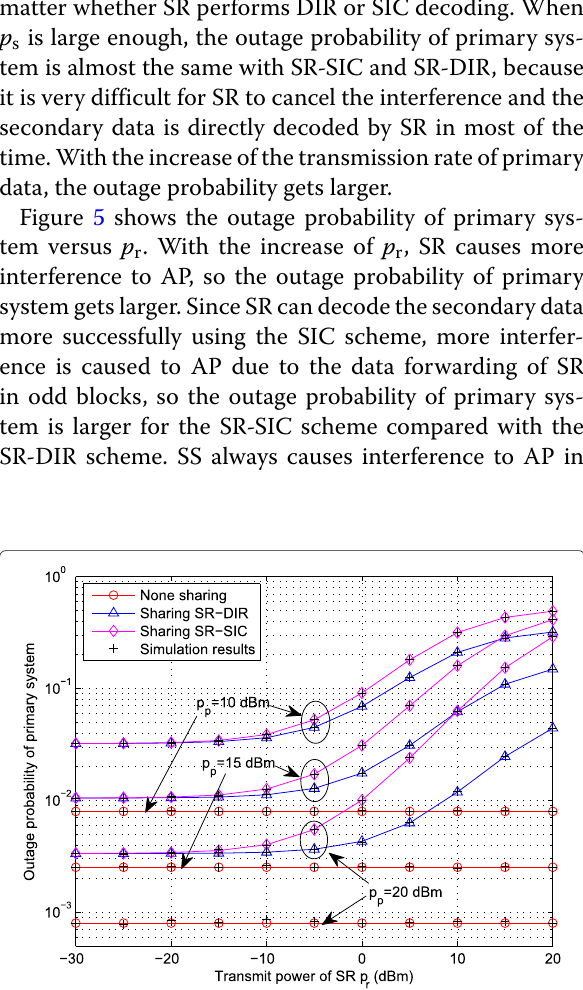
Fig.5 Outageprobability of primary system vs the transmit power of SR Fig. 6 Outageprobabilityof primary system vs the transmission rate R